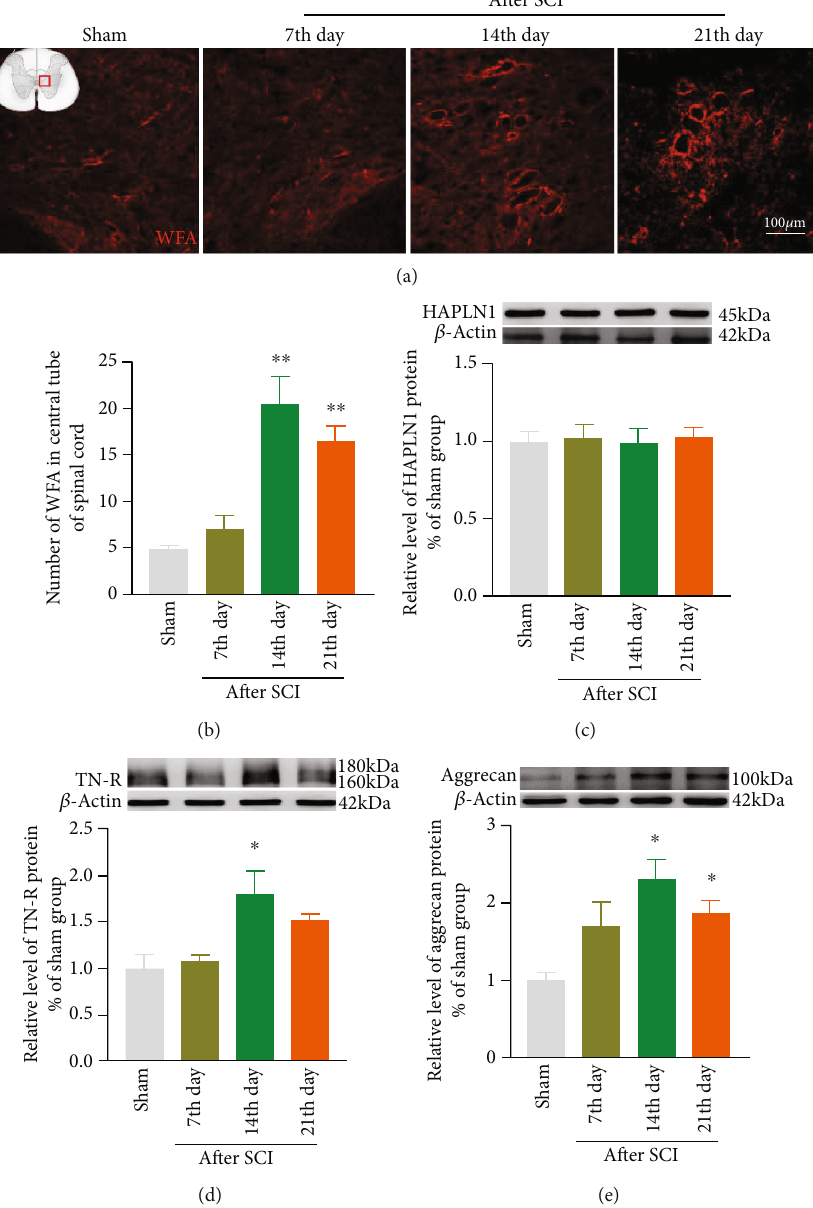
Figure 4: Expression changes of PNNs and their related proteins TN-R, HAPLN1, and aggrecan in the spinal cord after SCI. (a) Immuno fl uorescence representative diagram of changes in expression levels of WFA around the central tube of the spinal cord in the SCI group and sham group. (b) Quanti fi cation of the immuno fl uorescence data in panel (a), n = 3 . (c) Representative bands and statistics of TN-R, HAPLN1, and aggrecan in the spinal cord by Western blotting, compared with the sham group, ∗ P < 0 : 05 , ∗∗ P < 0 : 01 . All data are presented as the mean ± SEM